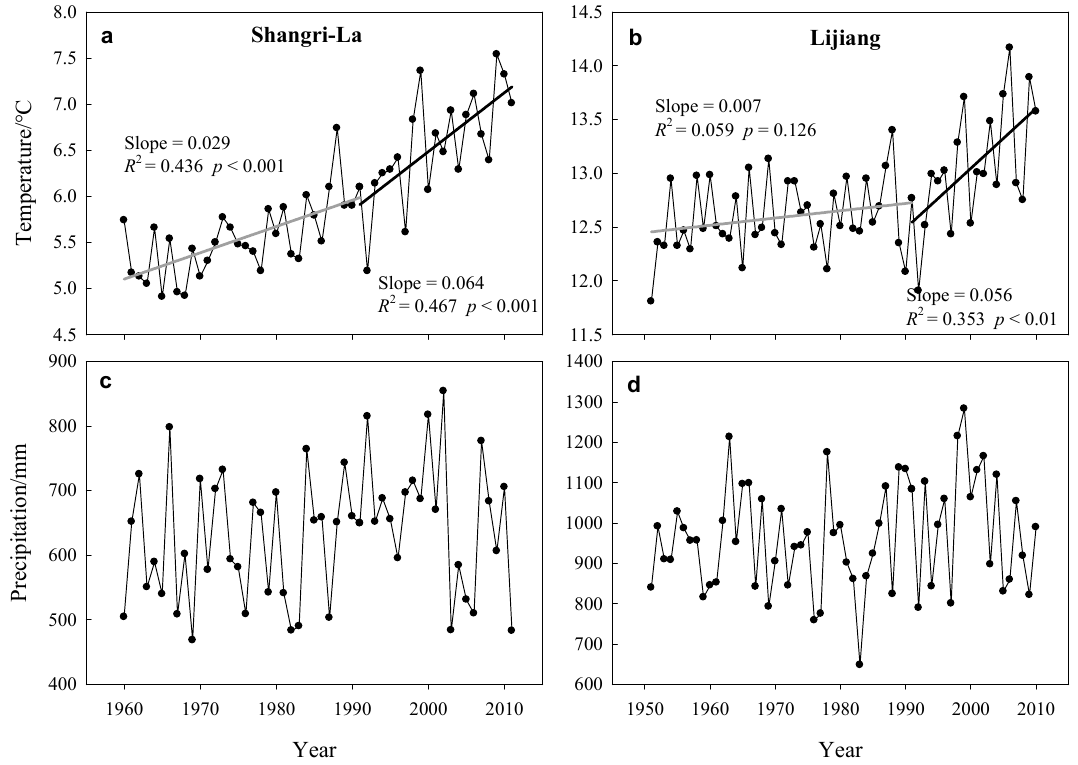
Figure 3. Temperature and precipitation variables for ( a , c ) Shangri-La (1960-2011) and ( b , d ) Lijiang (1951-2010) meteorological stations. R 2 indicates the proportion of the dependent variable that can be explained by independent variable in the regression model, p represents the significance level of the regression